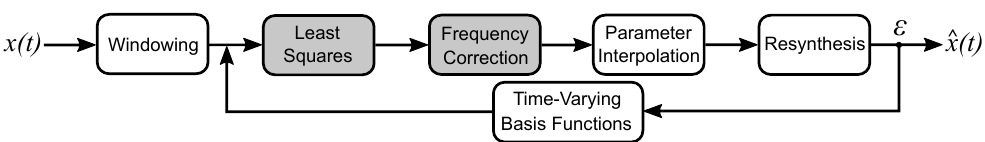
Figure 2. Block diagram depicting the modeling steps in the extended adaptive Quasi-Harmonic Model (eaQHM). The blocks with a dark background correspond to parameter estimation, while the feedback loop illustrates adaptation as iteration cycles around the loop. See text for the explanation of the symbols.